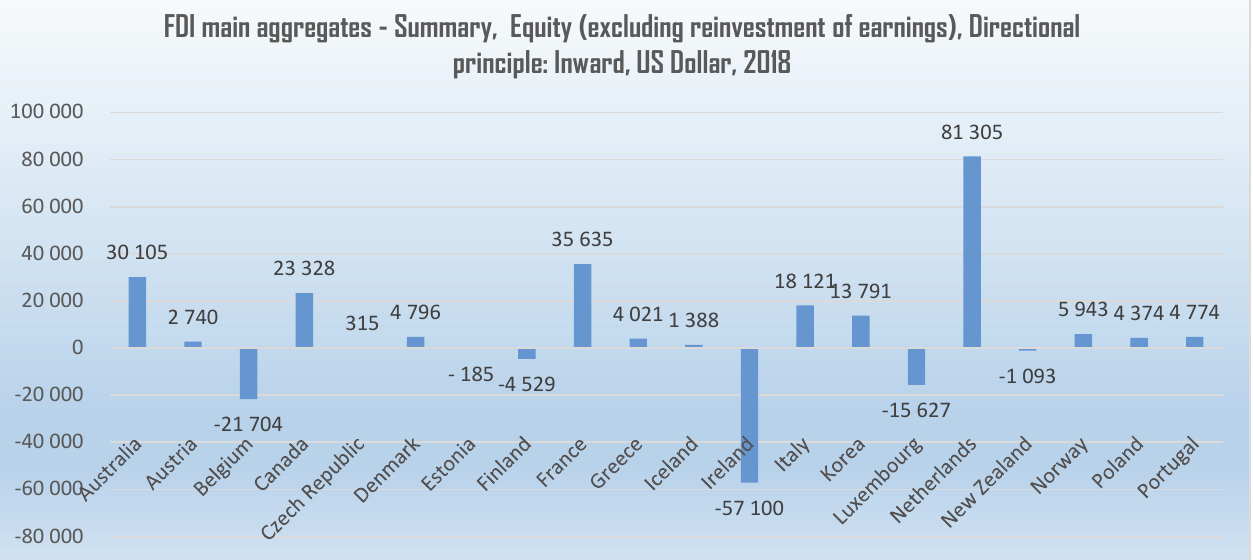
Fig. 3. FDI, Financial